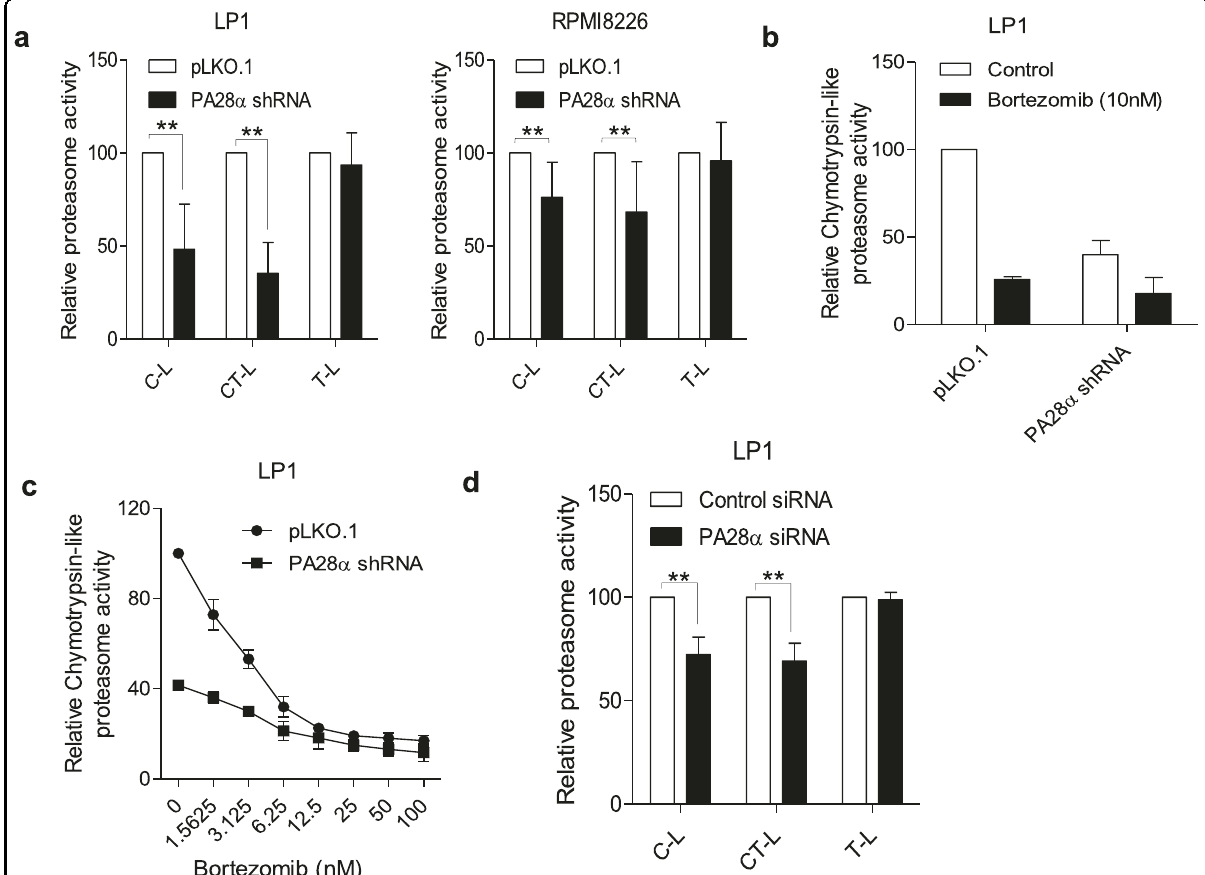
Fig. 3 Downregulation of PA28 α alters proteasome activity. a Proteasome fl uorogenic peptidase assays of cell lysates from LP1 and RPMI8226 PA28 α knockdown and scrambled control stable cells. b LP1 PA28 α knockdown stable cells were treated with 10 nM bortezomib for 2 h, cell lysates were obtained, and proteasome fl uorogenic peptidase assay was performed to check the chymotrypsin-like proteasome activity, SUC-LLVY-AMC as substrate. c LP1 PA28 α knockdown stable cells were treated with serial concentrations of bortezomib, chymotrypsin-like proteasome activity was checked as in b . d LP1 cells were transiently transfected with PA28 α siRNA for 72 h, proteasome fl uorogenic peptidase assays were performed as in a . ** P < 0.01, Student ’ s t